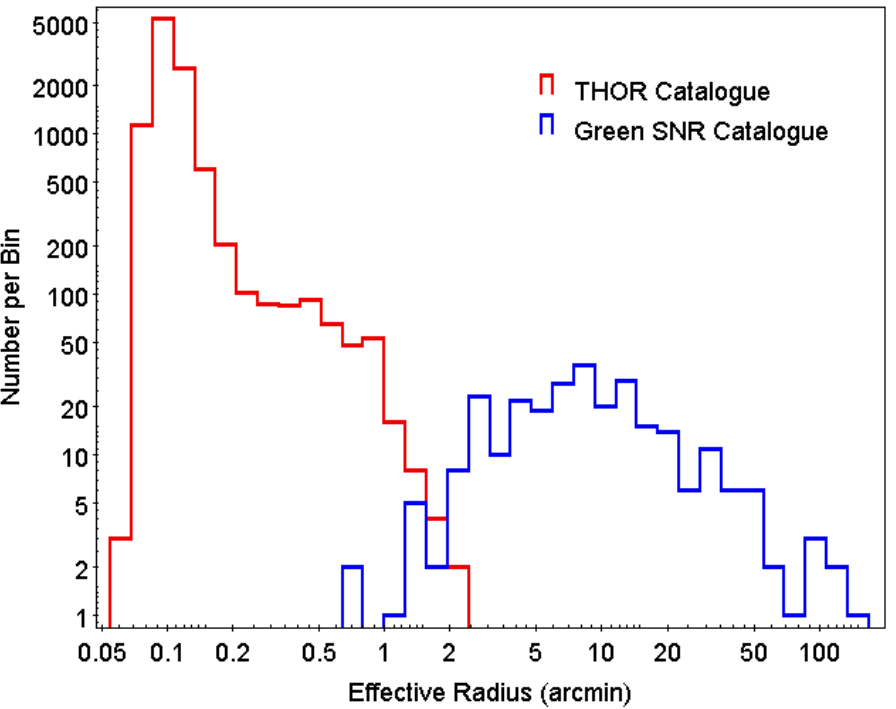
Figure 8. Distribution of angular radii of sources from the catalogue of [22] (red) and Green’s SNR catalogue